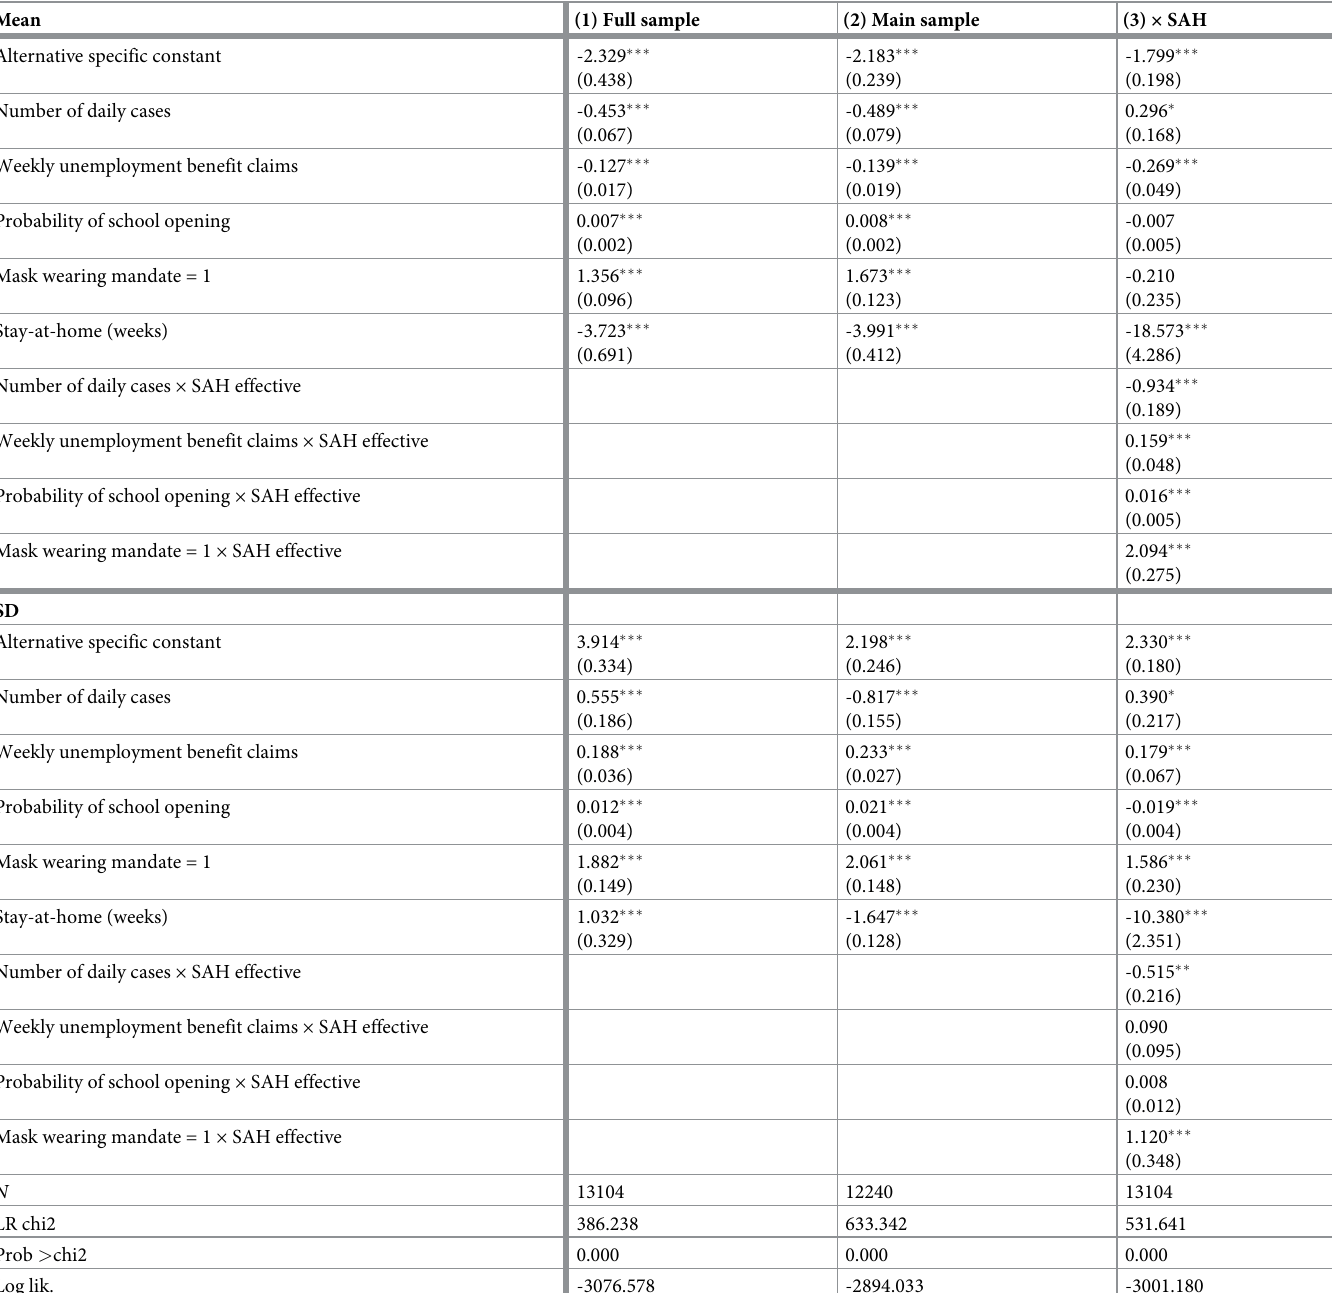
Table 2. The MMNL results estimated in preference